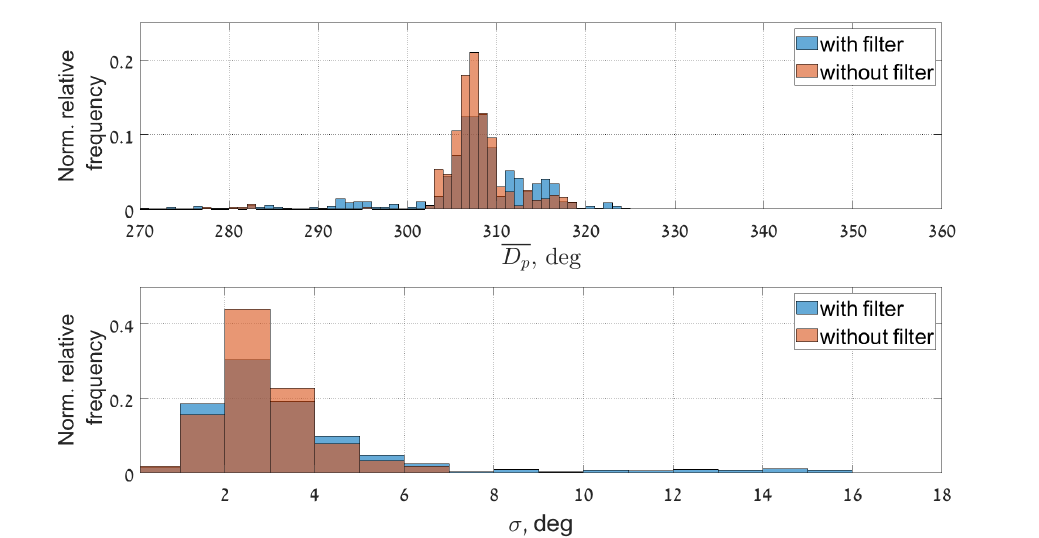
Figure 16. Normalized histograms of the mean values of the D p and its standard deviation given in a relative fraction to the total number of points, bin width for mean value is 1 deg and for standard deviation 1